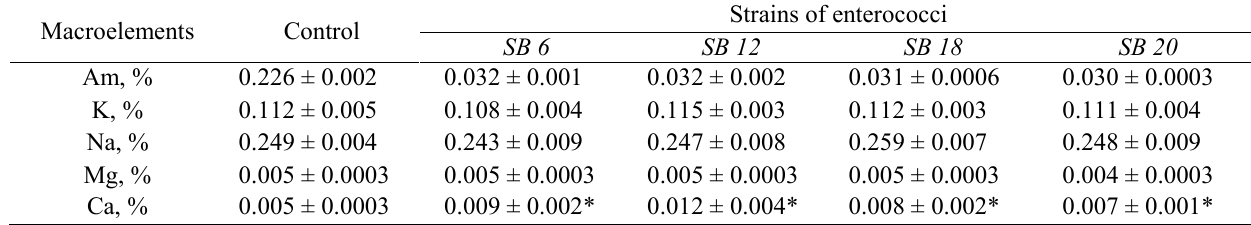
Macronutrients of experimental samples (M ± m, n =